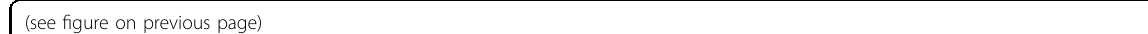
Fig. 2 CASK formed a complex with mint1-munc18-1 upon glucose stimulation and regulated mint1-munc18 interaction. a Immunomicrographs reveal membrane translocation of CASK in INS-1E cells following glucose stimulation (upper panel). Represented peak curve diagrams showing cellular distribution of CASK immuno fl uorescent signals measured by Image J with linear scanning (lower panel). b Subfractionation assay for membrane translocation of CASK upon glucose stimulation showed by western blot analysis (left panel). Quanti fi cation of the signal of CASKusing a densitometer (right panel). M: membrane fraction; C: cytosolic fraction; T: total lysate. c Overexpressing CASK/WT, CASK/ S51/395A, CASK/S51/395D mutants in INS-1E cells. Immunomicrographs showing the subcellular localization of different CASK mutants. d Histograms showing expression of CASK-S51/395A mutant inhibited insulin secretion. e The effect of Mint1 on insulin secretion in INS-1E cells (left panel). Right panel, western blotting showing the ef fi ciency of Mint1 knockdown (two distinct siRNA fragments, Ri-1 and Ri-2). f Western blot analysis showed that glucose-induced increased co-immunoprecipitation of endogenous CASK, Mint1 and Munc18-1 in a time-dependent manner in INS-1E cells. Non- immune serum (NS) was used as a negative control for immunoprecipitation. g The subcellular distribution of CASK, Munc18-1 and Mint1 before or after glucose stimulation. Cells were stained with anti-CASK (red) and anti-Munc18-1 (green) or anti-Mint1 (green) (left panel). Image pro plus was used to analyze the co-localization of the two proteins. Arrows indicates the membrane region. Note the overlap of the red and green signal peaks at the cell membrane after glucose stimulation (right